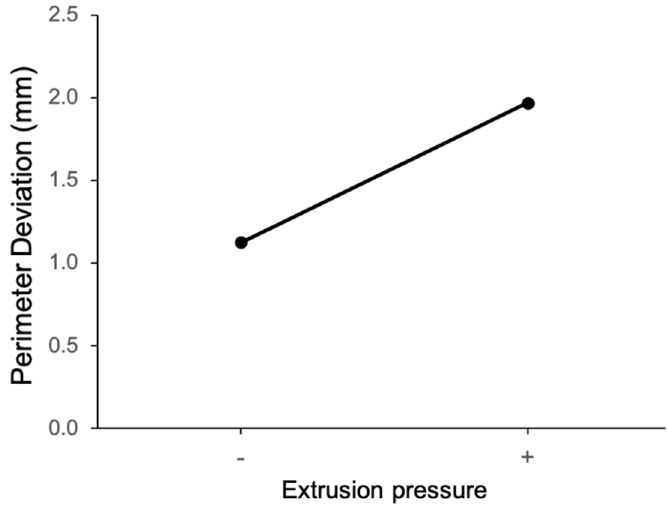
Figure 6. Main effect of extrusion pressure on perimeter deviation.